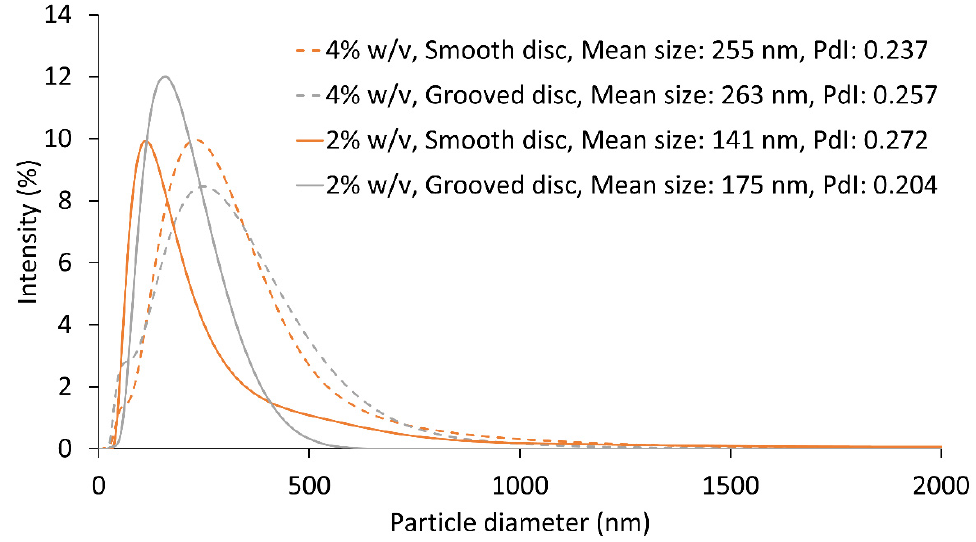
Figure 11. Effect of concentration on PSD at 18 mL/s, 1200 rpm, and 9:1 ratio for both grooved and smooth disc surfaces.